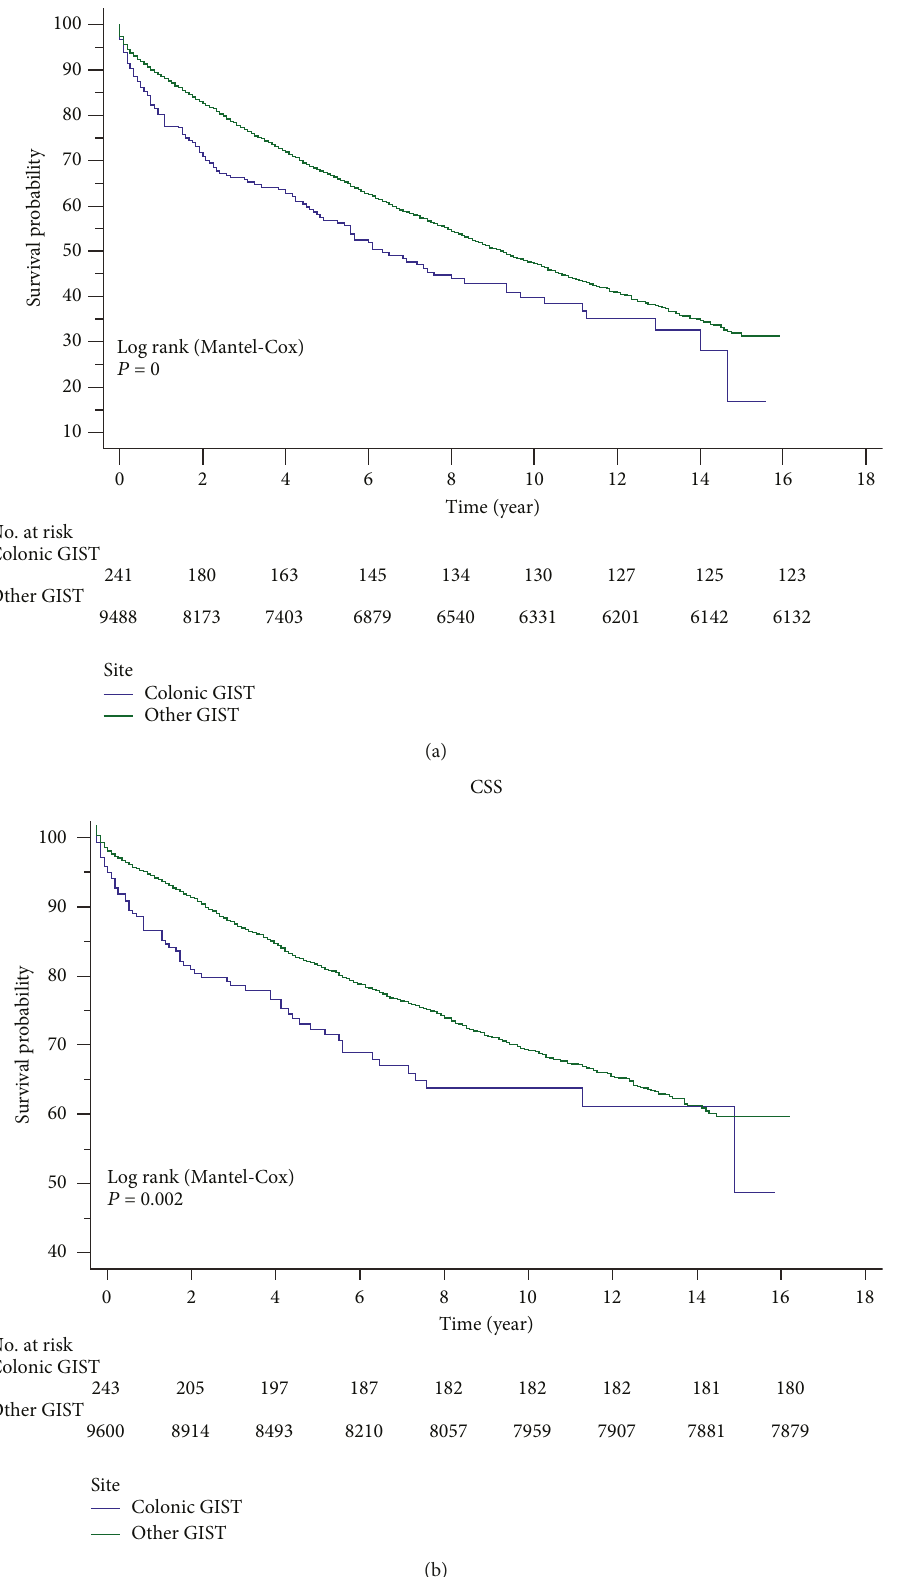
Figure 1: Survival analysis between colonic GISTs and other GISTs in